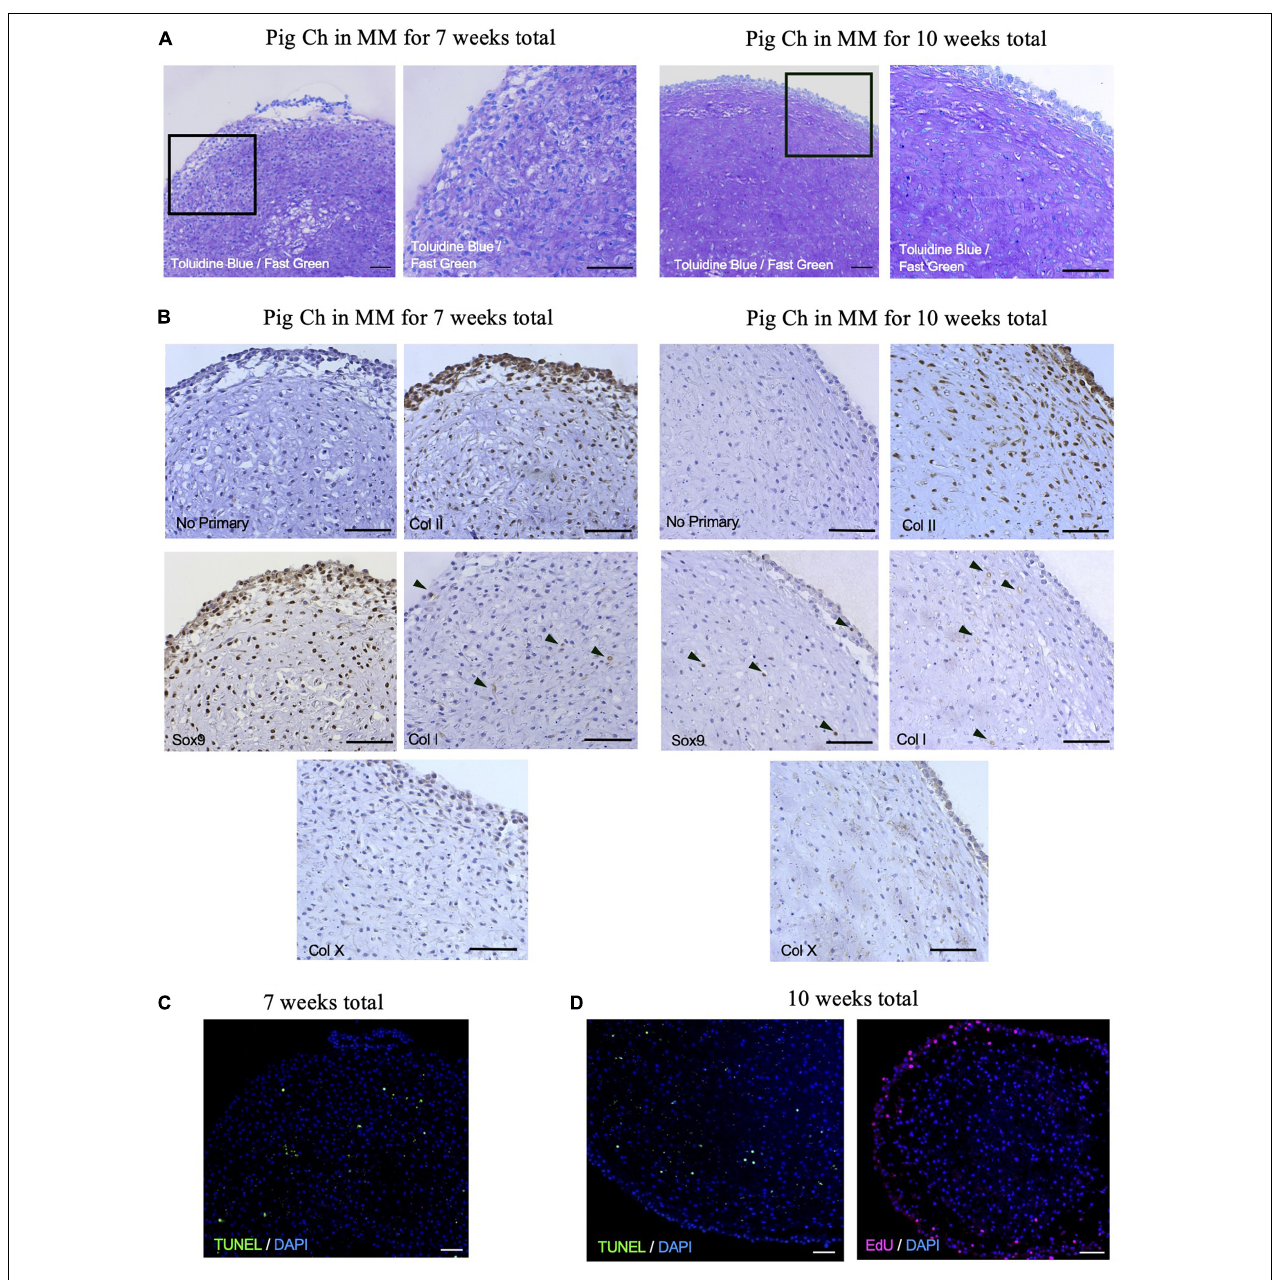
FIGURE 8 | Porcine articular chondrospheres self-organize and deposit extracellular matrix. (A) Toluidine Blue/Fast Green staining for GAGs in pig articular chondrospheres cultured for 7 weeks (left) or 10 weeks total (right). (B) Immunohistochemistry of collagen II, Sox9, collagen I, and collagen X in pig articular chondrospheres cultured for 7 weeks (left) or 10 weeks total (right). Black arrows demarcate positive staining, no primary antibody staining is provided as a negative control. (C) TUNEL staining to detect apoptosis shown in chondrospheres cultured for 7 weeks. (D) TUNEL staining (left) and EdU staining to detect proliferation (right) shown in chondrospheres cultured for 10 weeks. Scale bar = 100 µ